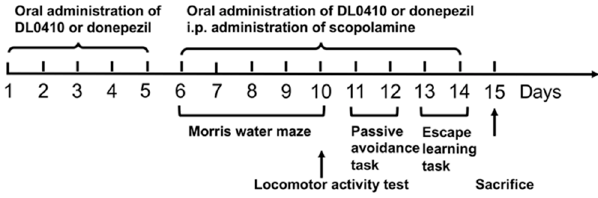
Figure 9. The schematic overview of the experiment.